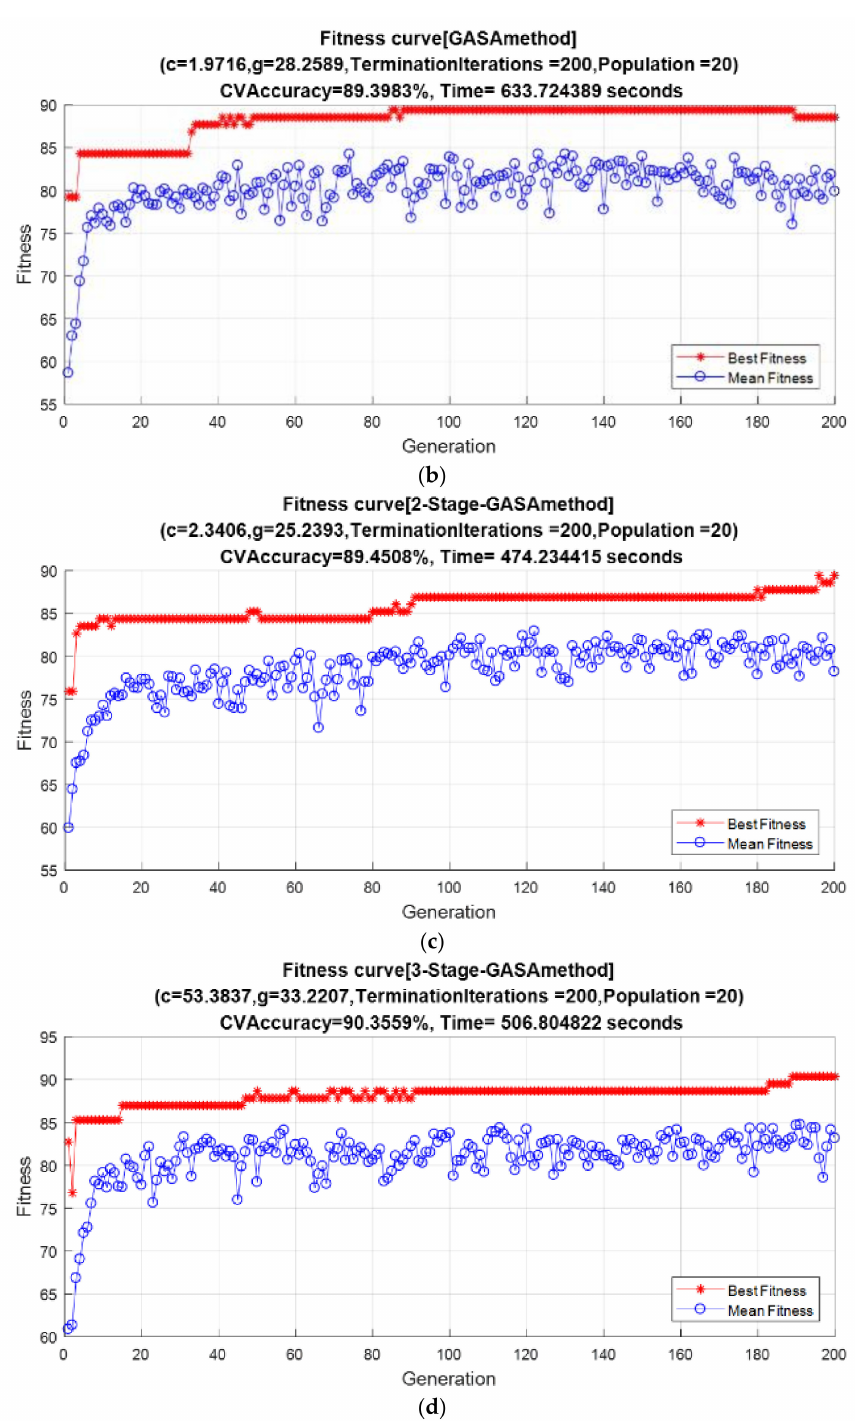
Figure 9. Results of four optimal feature selection methods: ( a ) The result of the GA–SVM method; ( b ) The result of the GA–SA–SVM method; ( c ) The result of the 2-stage GA–SA–SVM method; ( d ) The result of the 3-stage GA–SA–SVM